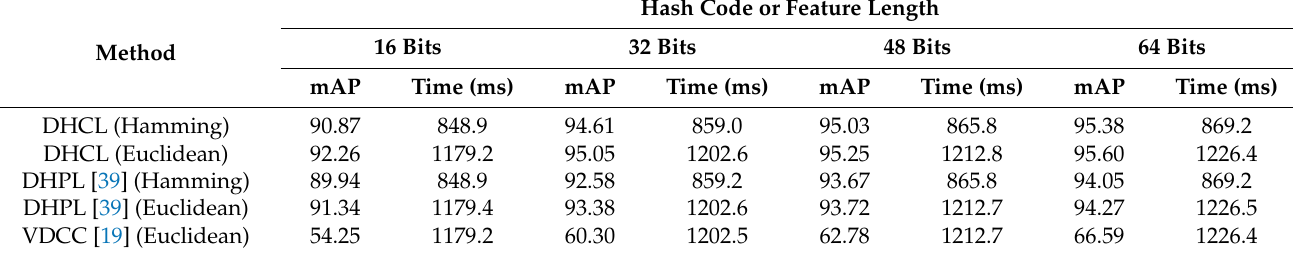
Table 3. Results of different retrieval methods on RSD46-WHU. The respectively lengths of the hash codes and features are set as 16 bits, 32 bits, 48 bits and 64 bits. The evaluation criterion for retrieval accuracy is mAP. Finally, the evaluation criterion for time is the average retrieval time, in milliseconds.